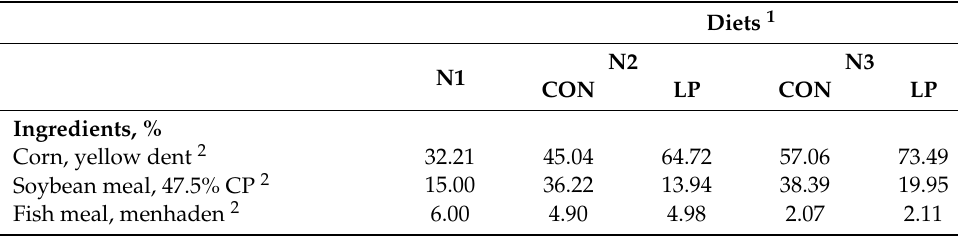
Table 1. Ingredients and chemical composition of experimental diets (as-fed